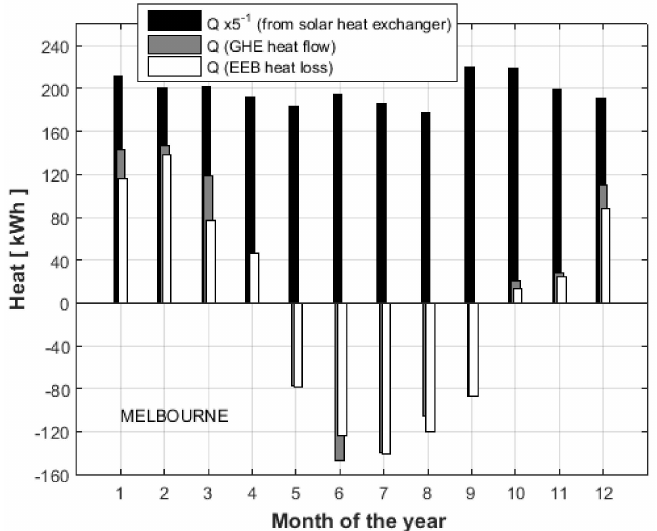
Figure 11. Monthly heat flow across the EEB for Melbourne, for the scenario of 12 PVTs paired with 12 BHEs and for the 6th year of